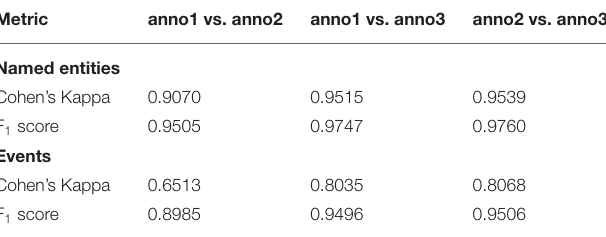
TABLE 5 | Summary of inter-annotator agreement